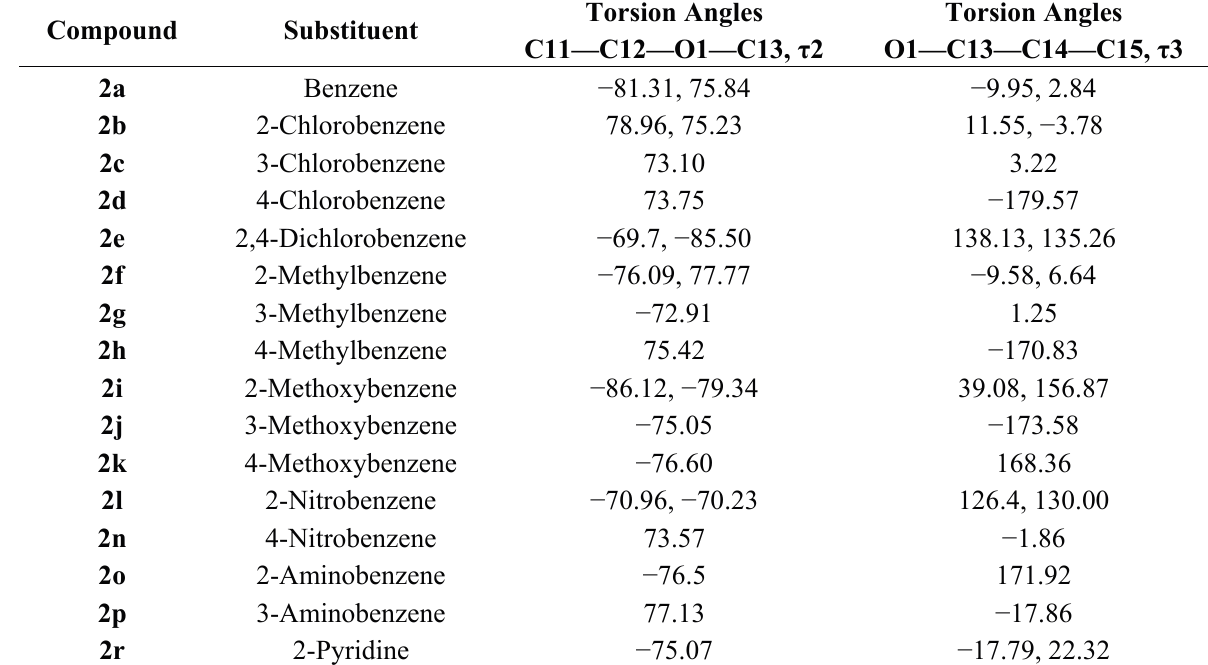
Table 2. Summary of the C11—C12—O1—C13 and O1—C13—C14—C15 torsion angles.